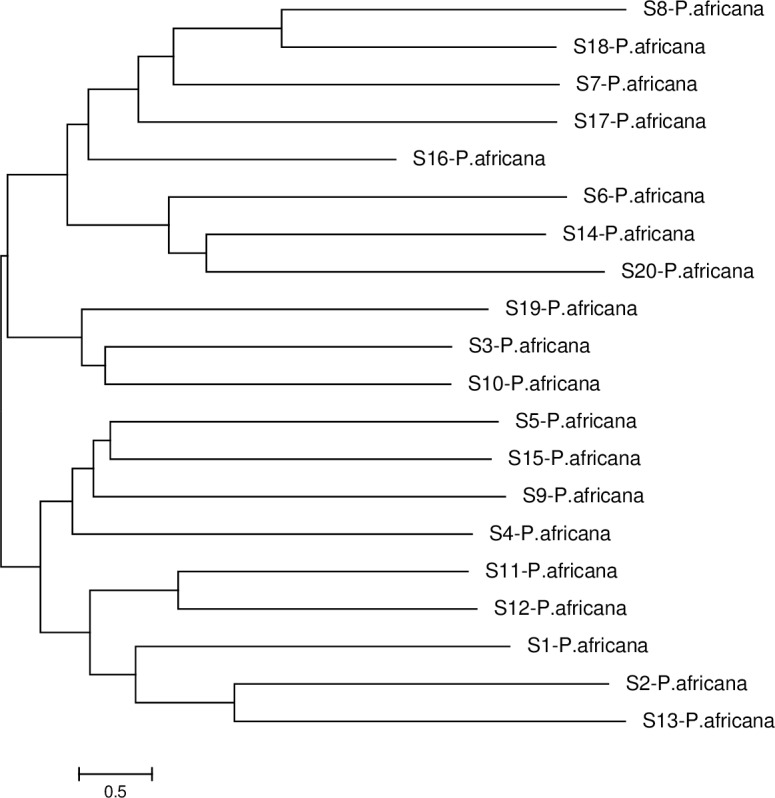
Phylogenetic (minimum evolution) tree of P. africana S-RNase intron 2 sequences, showing the relationship among alleles.